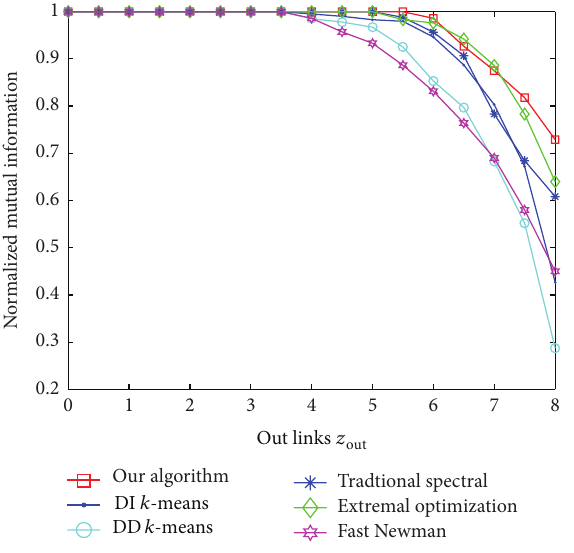
Figure 2: The NMI of the six methods with the change of 𝑧